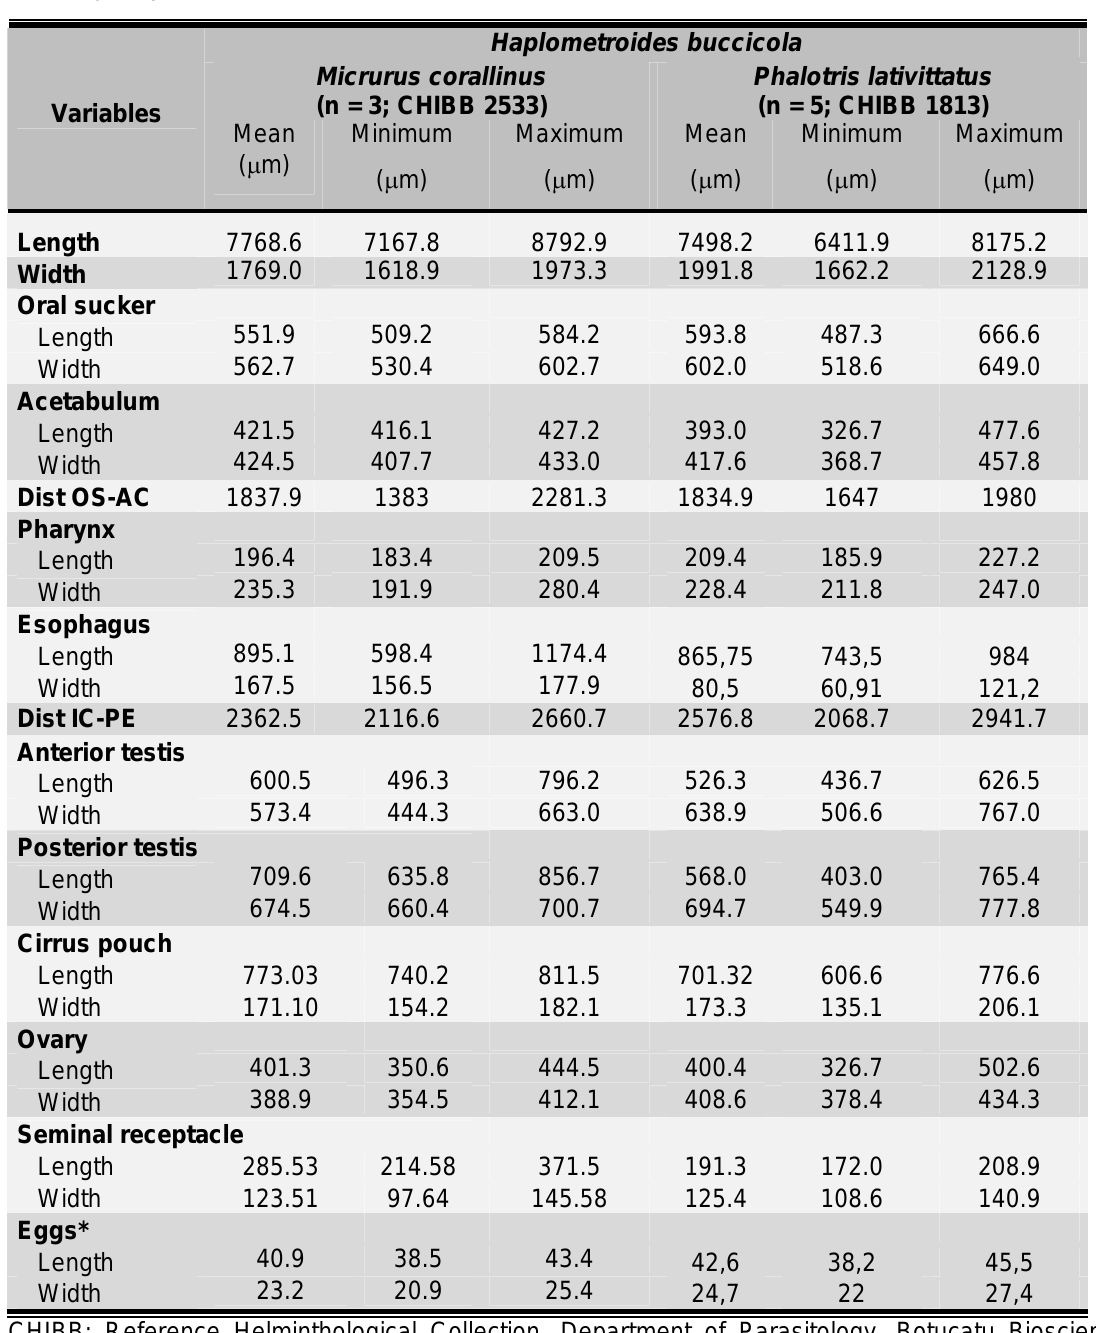
Table 1. Morphometric data of Haplometroides buccicola found in the esophagus of Micrurus corallinus (Elapidae) and Phalotris lativittatus (Colubridae) from the municipality of Botucatu, São Paulo,